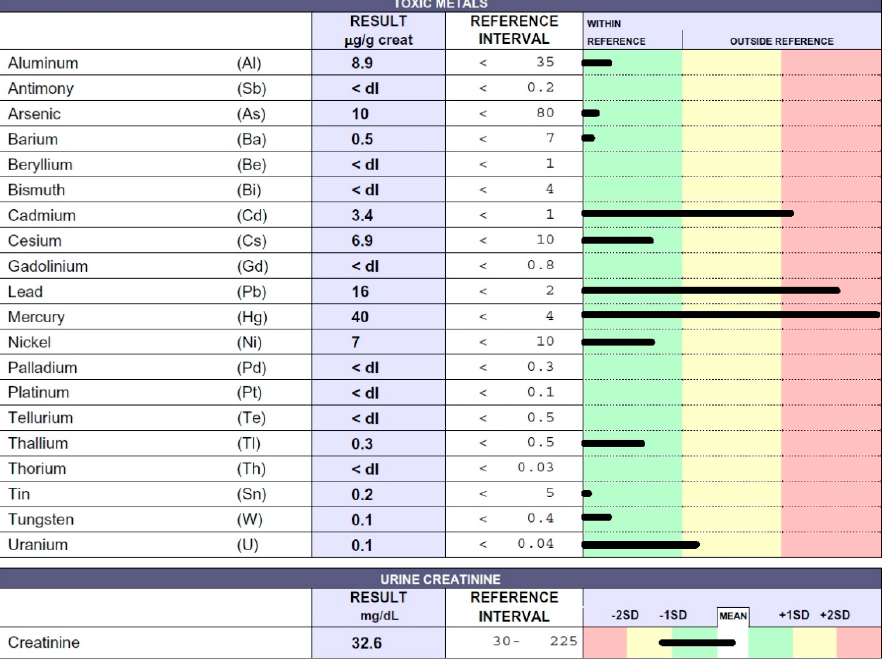
Figure 2. Toxic-metal levels measured by inductively coupled plasma mass spectrometry (ICP-MS) method in the patient’s urine collected during the 12 h following EDTA “challenge” (chelation test) reported in micrograms ( µ g) per g creatinine. The 65-year-old female patient was affected by OP intoxication.